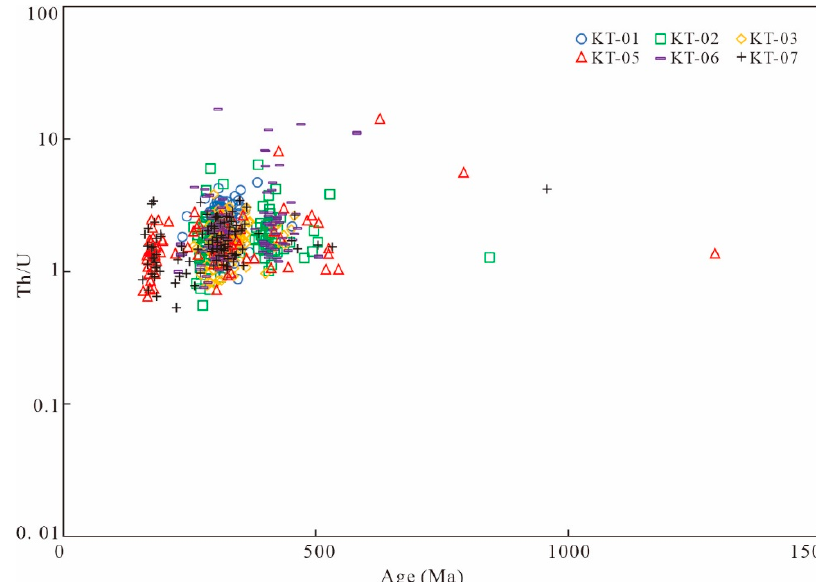
Figure 7. Representative detrital zircon micro-region CL image and age data (Ma). The white data is U-Pb age, and the yellow data is Hf two-stage model age. The red and yellow circles are laser ablation positions.